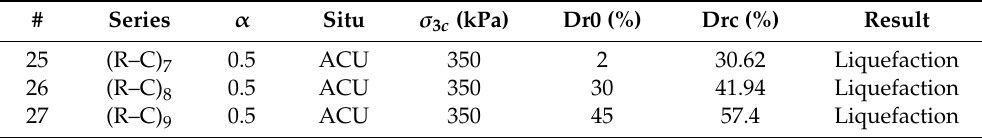
Figure 6. Examples of ( a ) preparation and ( b ) tested triaxial sample.